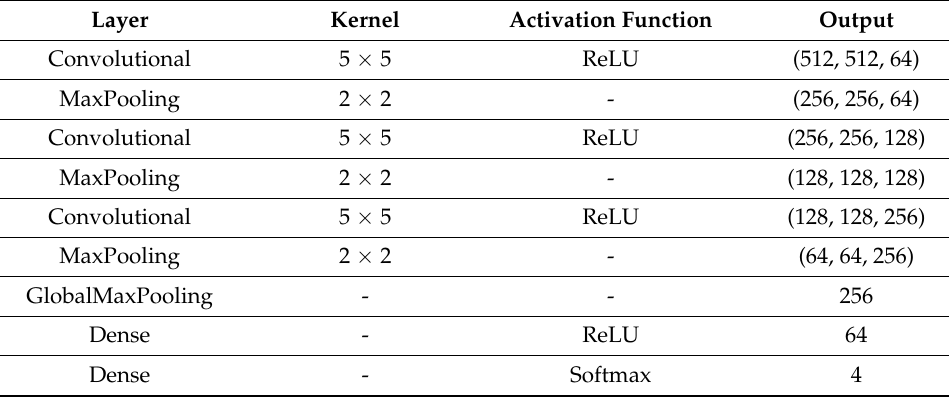
Figure 16. Generic architecture of a multi-class classi fi cation neural network. Table 3. Proposed architecture for the classification